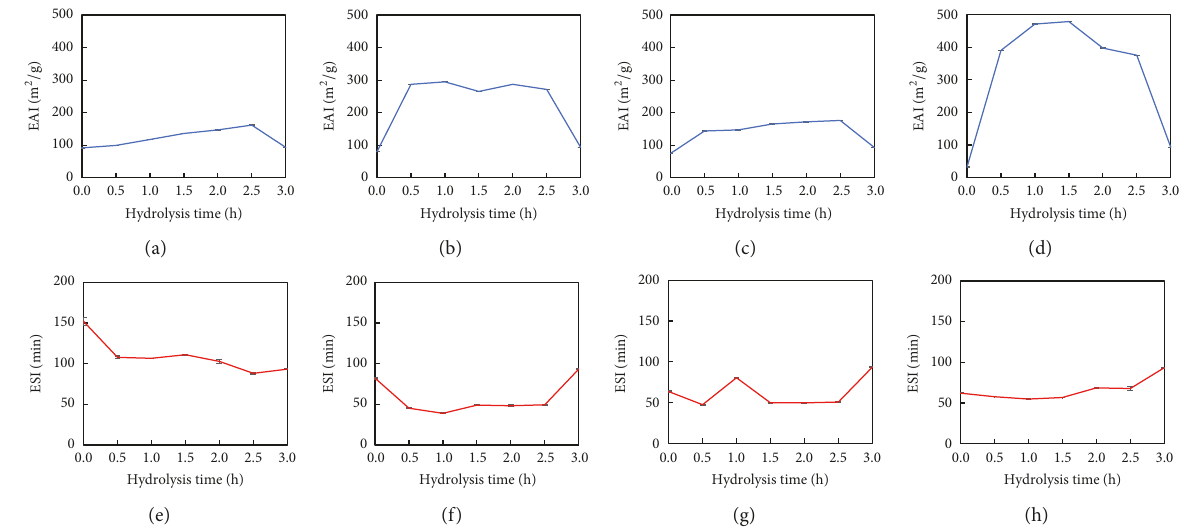
Figure 7: EAI and ESI analysis of (a & e) nonextruded, (b & f) Ex60-HSPP, (c & g) Ex80-HSPP, and (d & h)